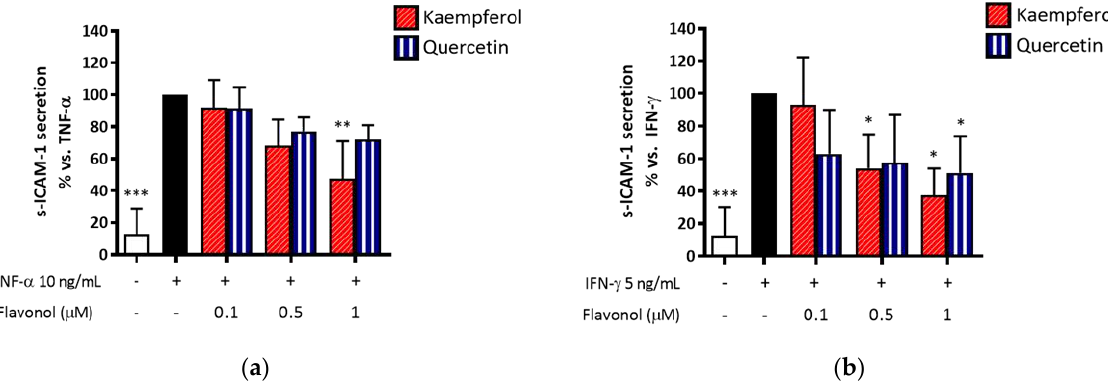
Figure 14. ( a ) Effect of quercetin and kaempferol treatment (0.1–1 µ M) on s-ICAM-1 release in HaCaT cells stimulated with